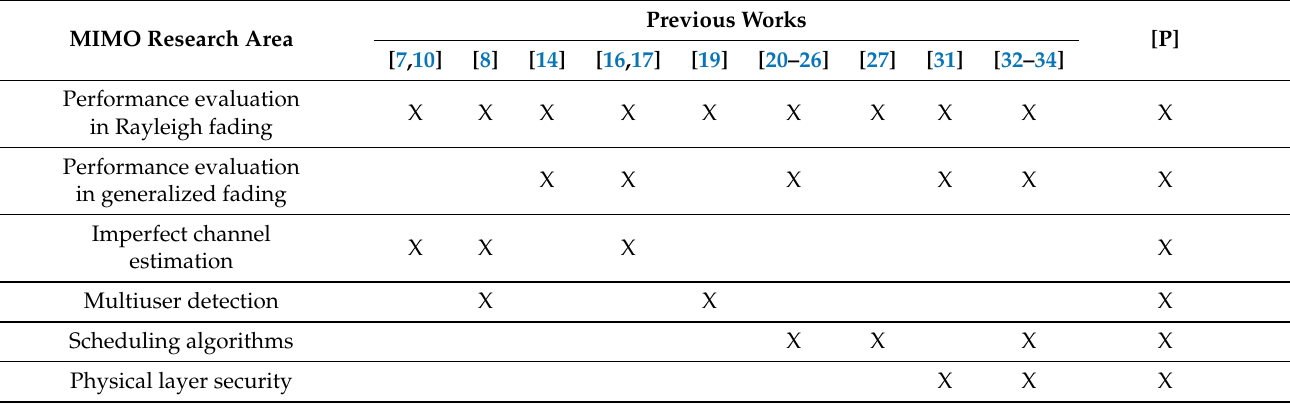
Table 1. Related work